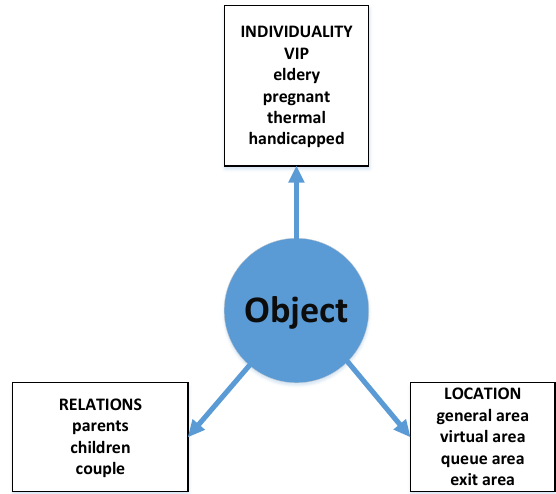
Figure 4. Context model for a queue management